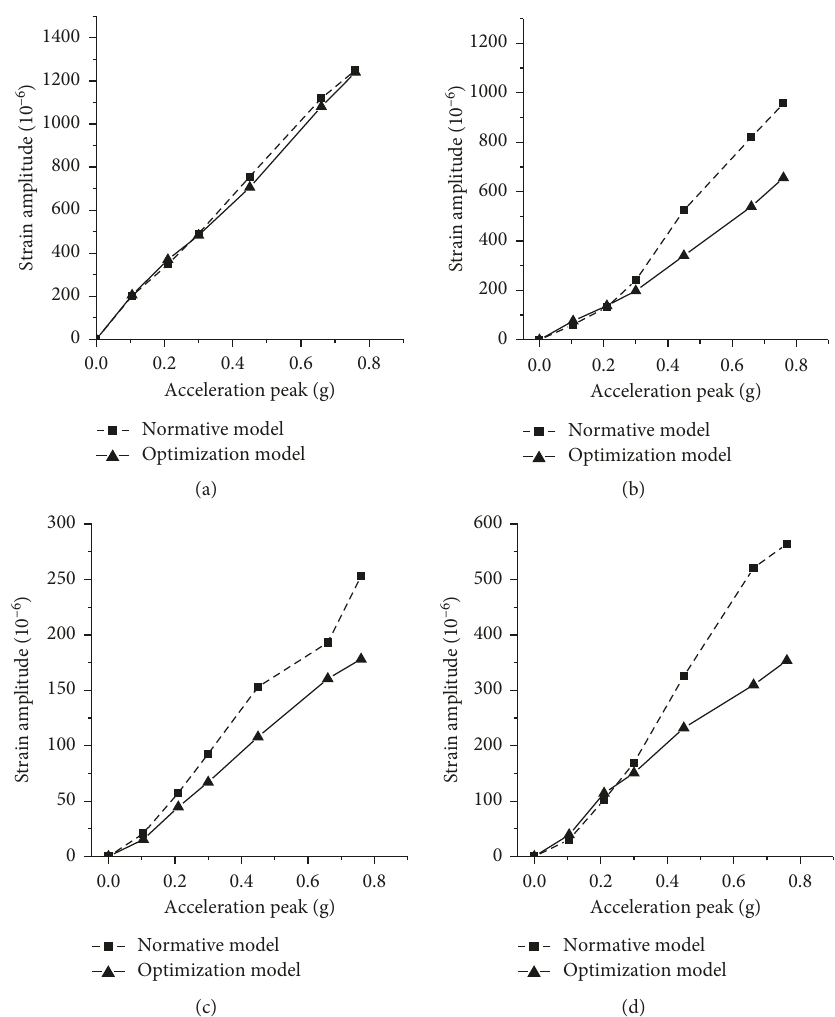
Figure 11: Damage evolution of vertical component. (a) Wall limb at 1 story, (b) frame column at 1 story, (c) wall limb at 11 story, and (d) frame column at 11